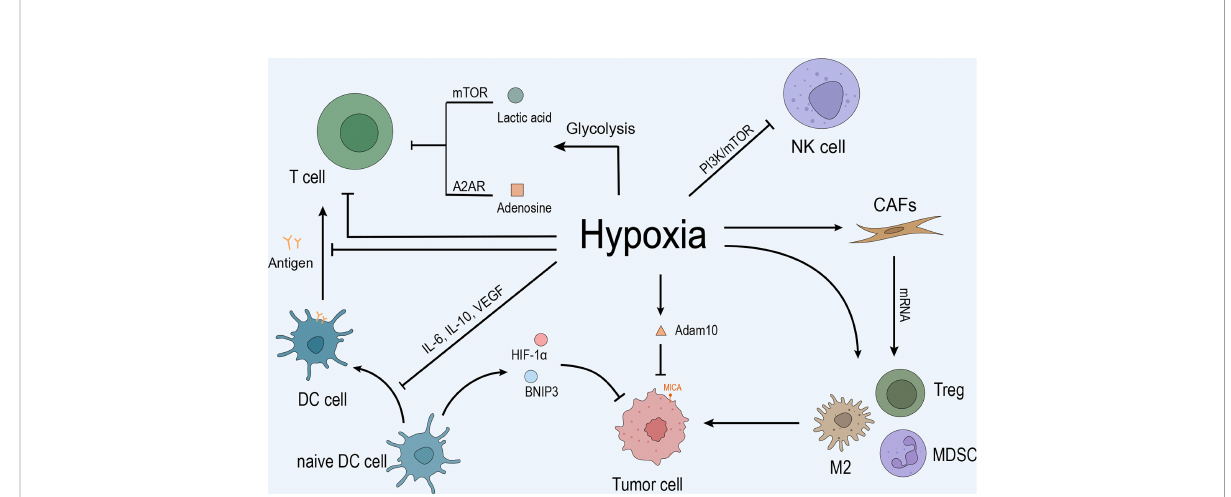
FIGURE 1 Hypoxia inhibits the immune response by inhibiting immune cells, recruiting immunosuppressive cells, regulating CAFs, promoting tumor cell growth, and mediating immune escape. (A) Anoxic metabolites, lactic acid, and adenosine inhibit T cell effector function and proliferation by blocking the mTOR pathway and interacting with the A2A receptor on the T cell surface. Hypoxia promotes T cell apoptosis and directly inhibits T cell proliferation and differentiation. Hypoxia upregulates IL-10, VEGF, and other cytokines through HIF-1 a and inhibits the differentiation and maturation of DCs, leading to the inhibition of T cell function. Moreover, hypoxia-induced high levels of HIF-1 a and BNIP3 promote programmed cell death in tumor cells captured by DC. In addition, hypoxia inhibits NK cell function by activating the PI3K/mTOR signaling pathway. (B) Hypoxia induced the mRNA expression of TGF- b , VEGF , IL-6 , IL-10 , and PD-L1 and promoted CAF participation in the recruitment of MDSCs, Tregs, and type 2 TAMs to maintain the immunosuppressive state of the microenvironment, promoting tumor cells to evade immune surveillance. (C) Hypoxia upregulates the expression of MMP adam10 and induces the immune escape of tumor